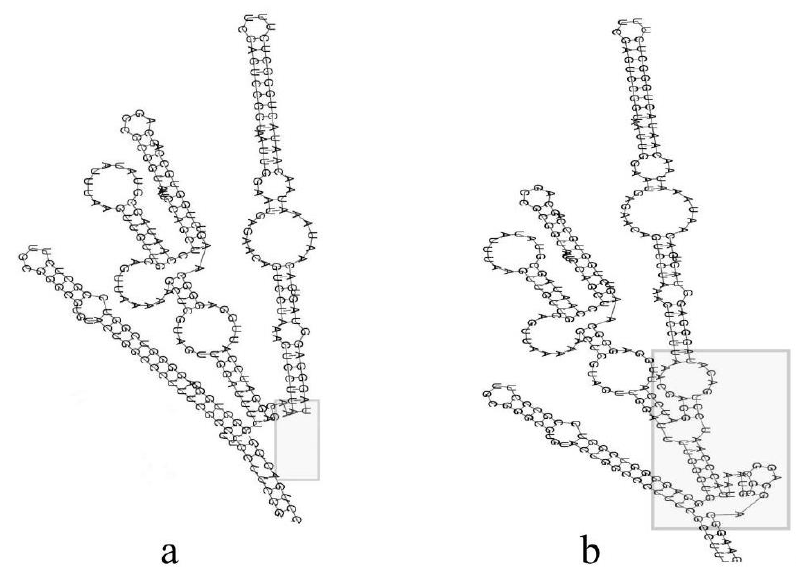
Figure 7. Prediction of the secondary structure of 18S rDNA. ( a ) Chara zhengzhouensis ; ( b ) C. connivens.